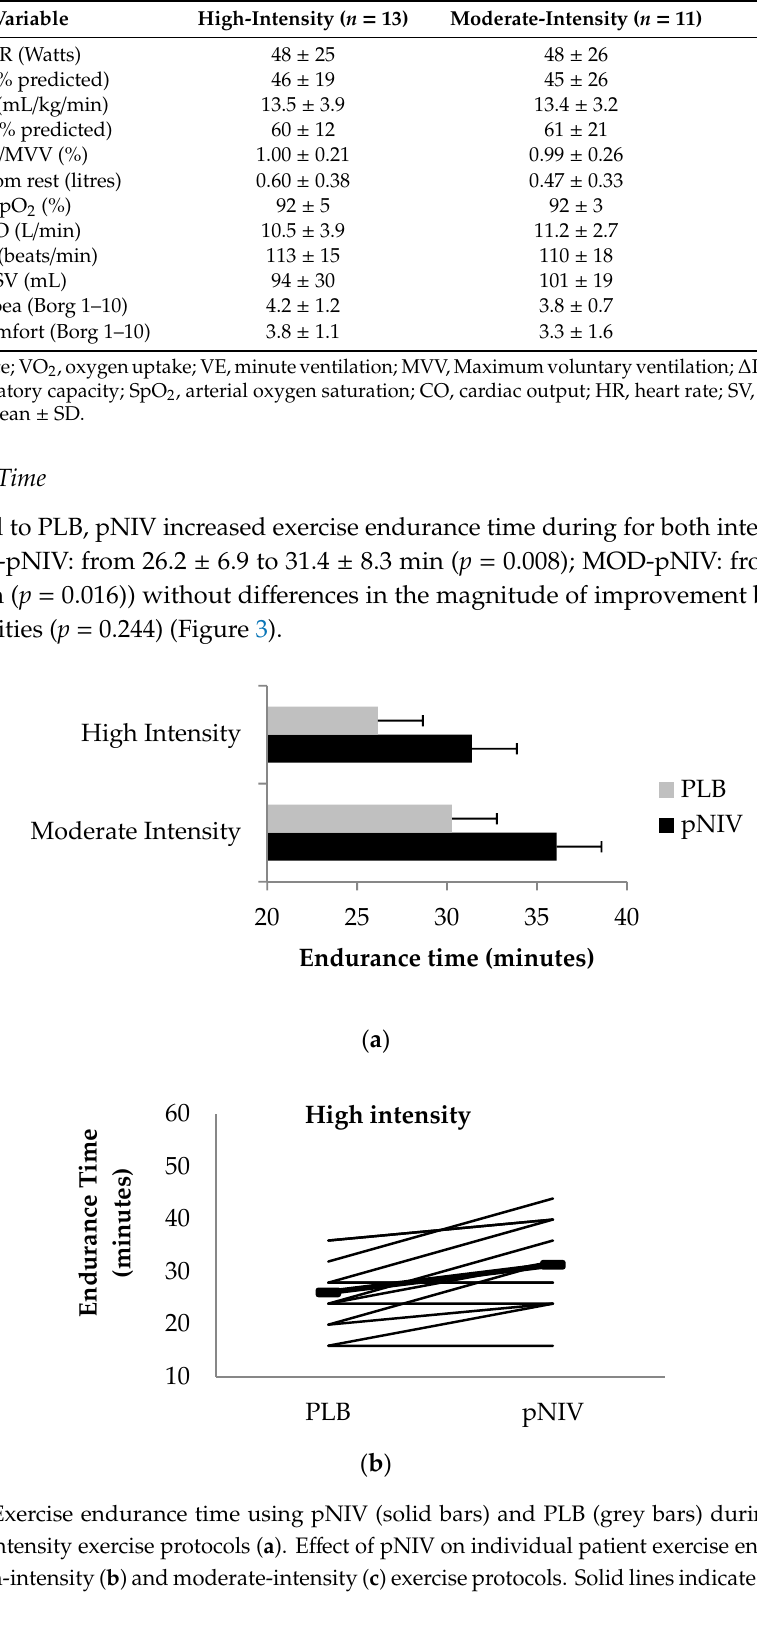
Table 2. Peak physiological variables at the limit of tolerance during cardiopulmonary exercise test (CPET).